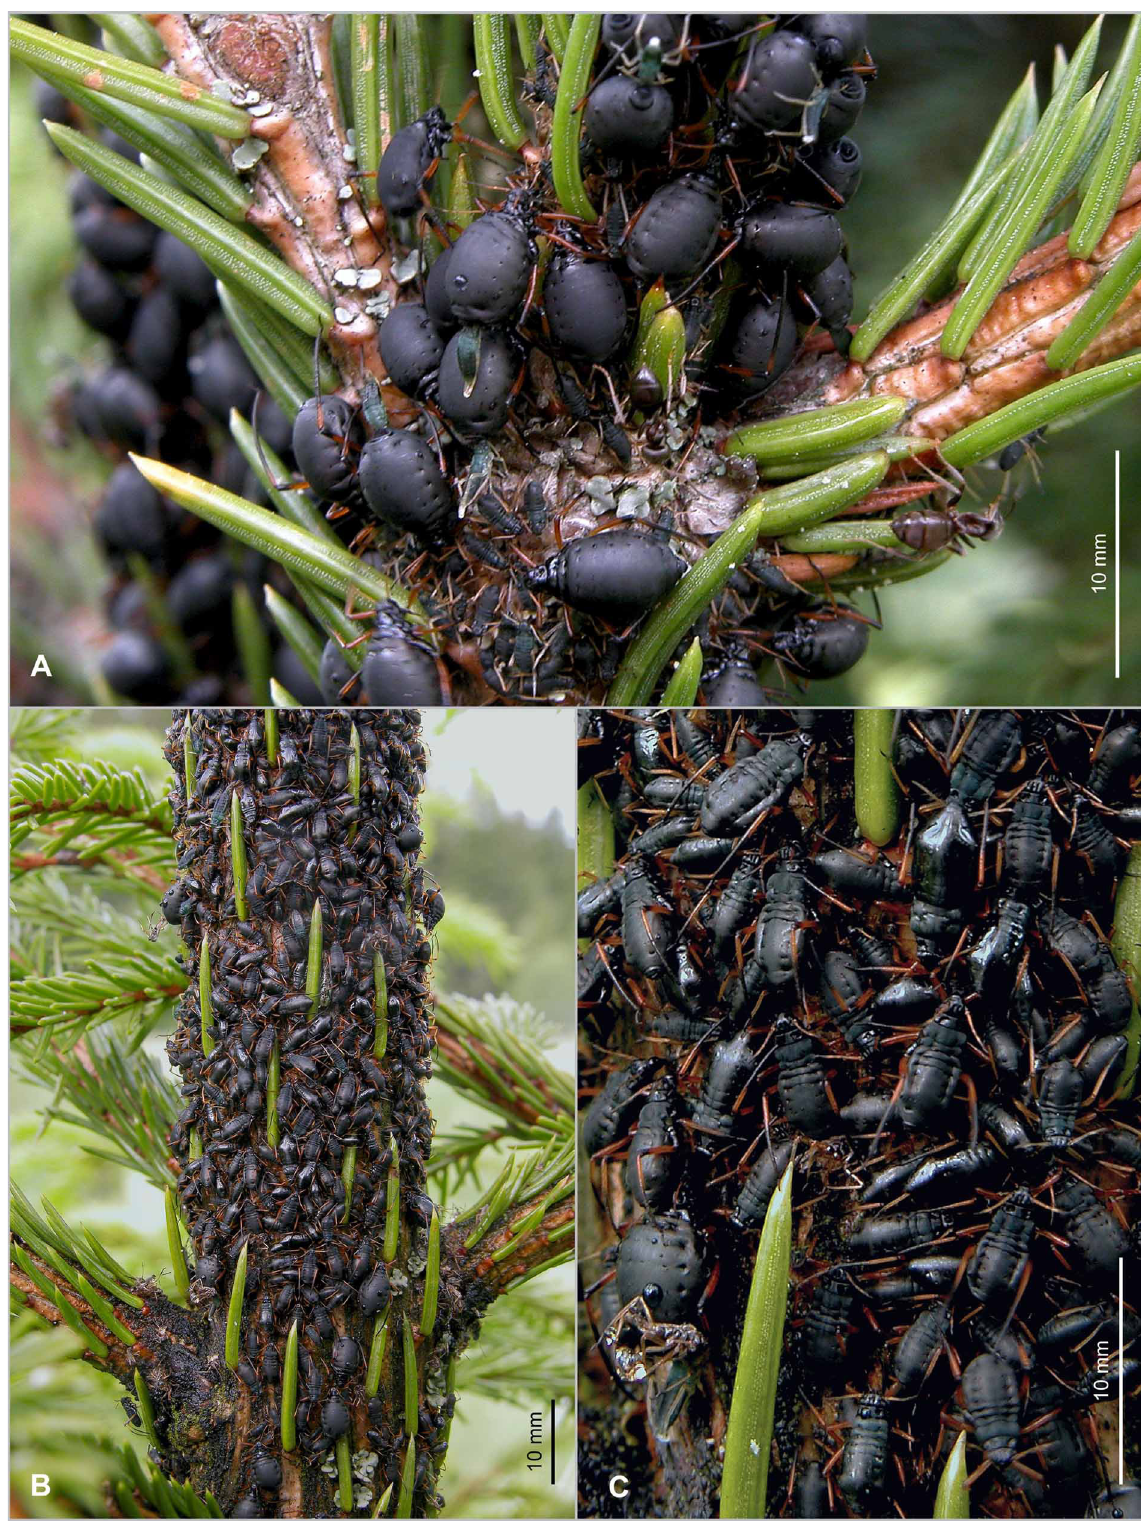
Fig. 28. Cinara (Cinara) piceae (Panzer, 1801) on Picea abies . Colonies on upper part of trunk of young tree. A . Apterae with small nymphs, attended by Lasius niger (Linnaeus, 1758). B–C . Half-grown and full-grown young alatae, and a few